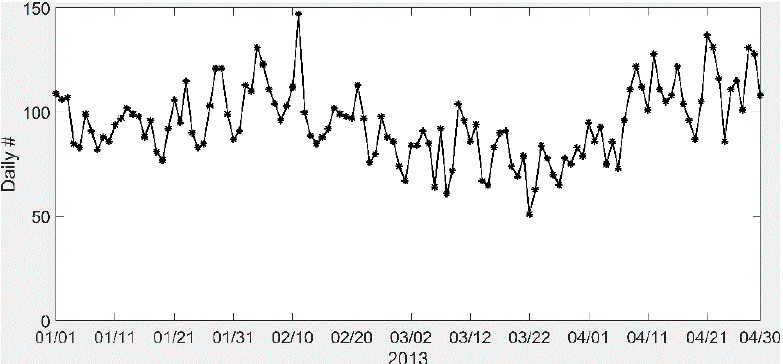
Figure 2. Observed daily emergency room (ER) visits for asthma in the Atlanta area (20 counties included) in 2013.